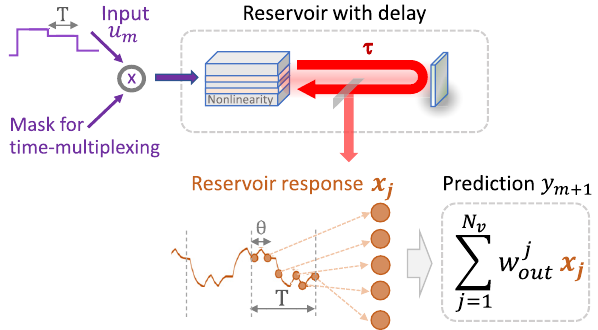
Figure 1: Scheme of a time multiplexed reservoir computer with a nonlinearity (e.g., a laser) subjected to delayed